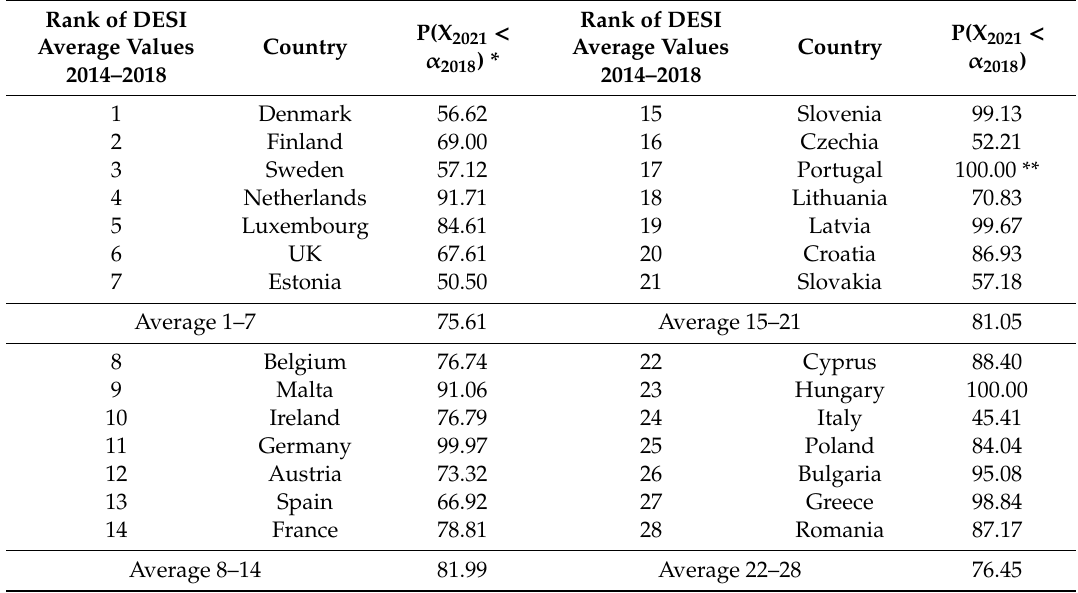
Table 9. The Probability that the Value of the AROPE Indicator in 2021 will be lower than in 2018, %. Rank of DESI Average